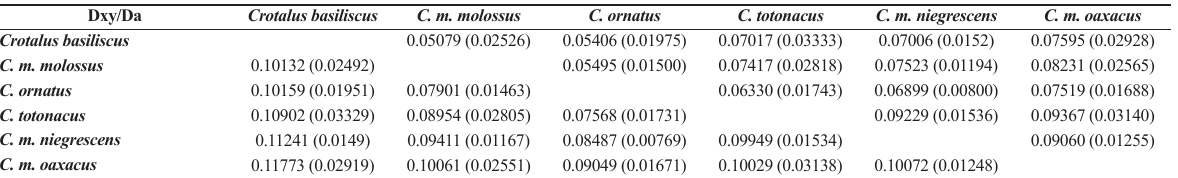
Table 1. Genetic distances matrix estimated considering the 15% missing data-dataset, among six main clades. The average number of nucleotide substitutions per site between populations ( Dxy ) values are below diagonal and the number of net nucleotide substitu- tions per site between populations ( Da ) above diagonal. In all cases standard deviation values are within parentheses.